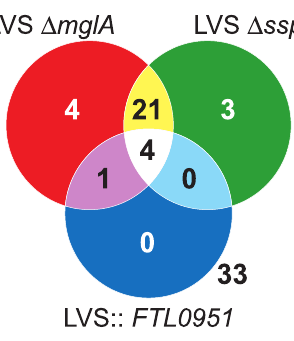
Figure 5. MglA and SspA Control the Expression of a Similar set of Genes Venn diagram representation of the overlap between genes controlled by MglA, SspA, or growth rate. Each circle represents those genes whose expression was altered by a factor of 3 or more ( p , 0.01) in the corresponding mutant strain compared to wild-type, and whose expression altered by a factor of 3 or more ( p , 0.01) in the other mutant